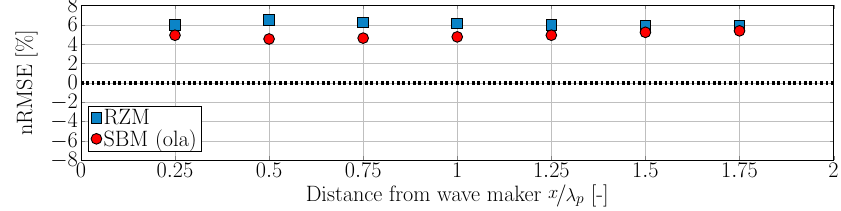
Figure 19. Results for the wave generation test case for the polychromatic sea state generated with the relaxation zone method and static boundary method, implemented in the olaFLOW